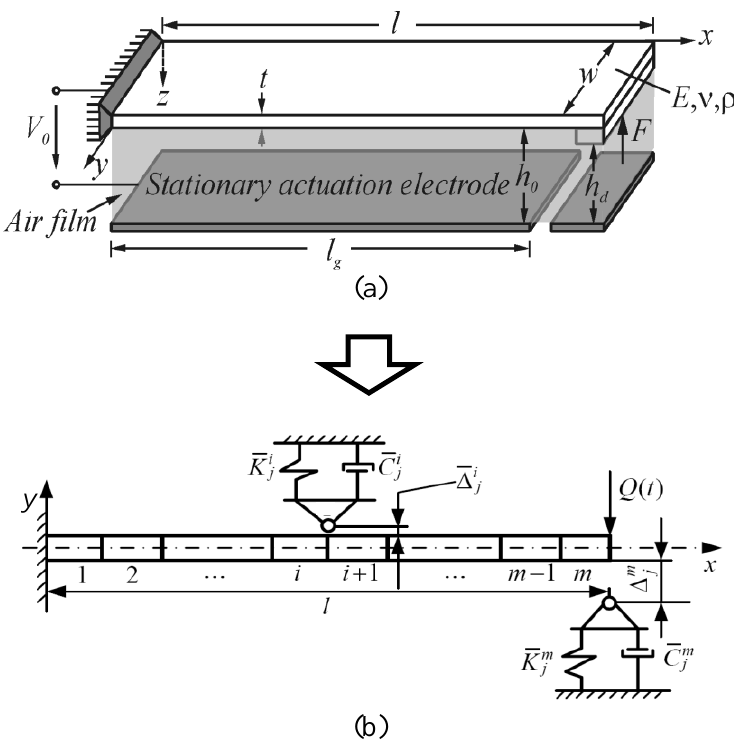
Figure 1. Schematic of: (a) generalized model of common electrostatic contact-type MEMS device operating in ambient air, (b) developed 2-D finite element model of impacting cantilever